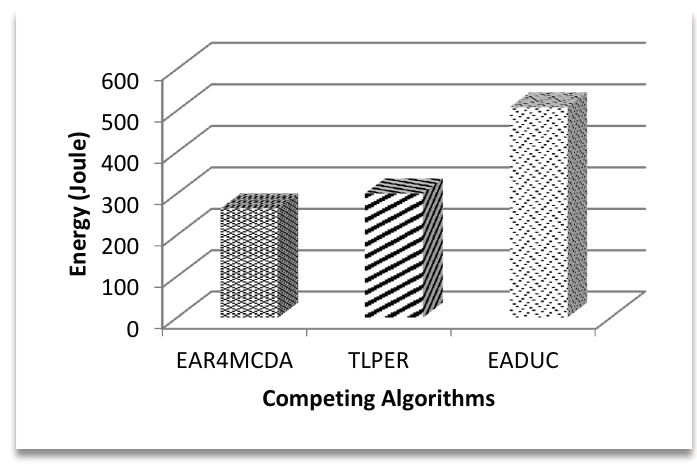
Figure 14. Energy consumption for total throughput in first 300 s.